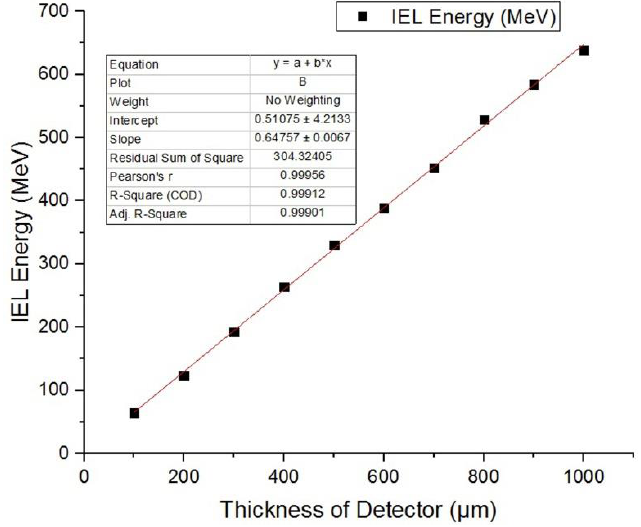
Figure 13. Relationship between ionizing energy deposition (IEL) produced by neutrons and the thickness of SDD.